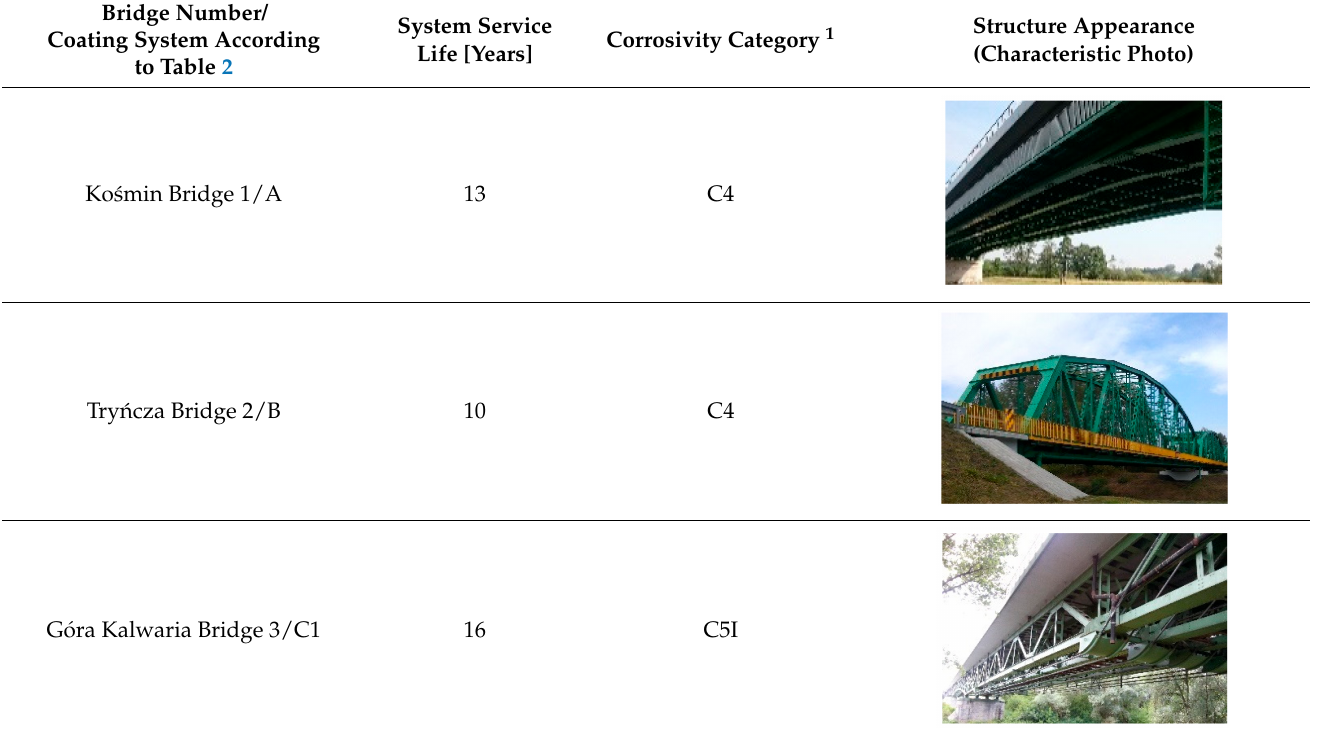
Table 1. Objects with the applied coating systems and the characteristics of operating